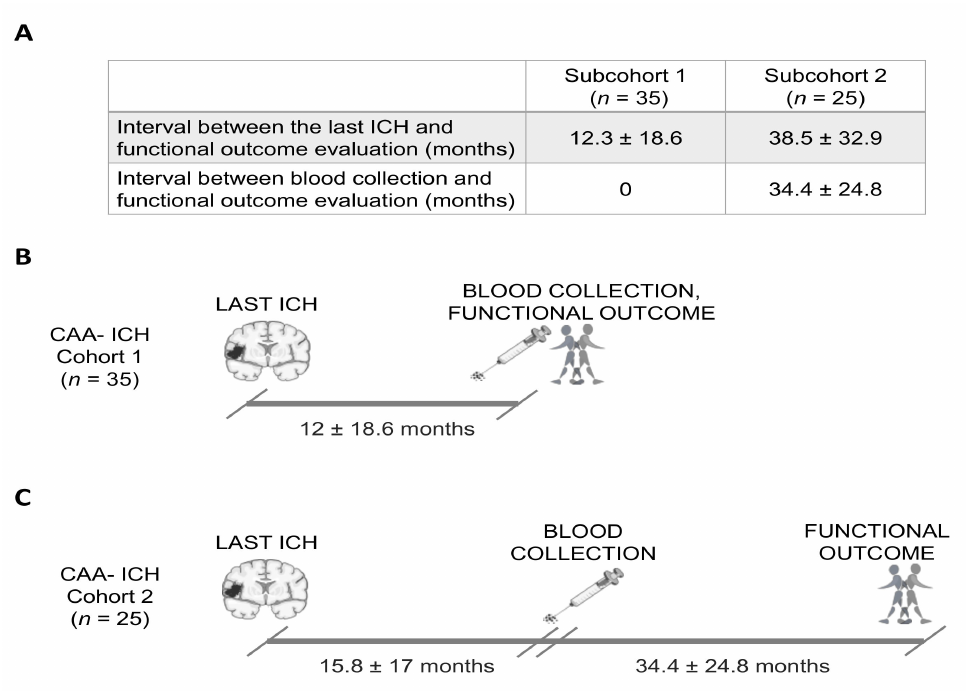
Figure A1. Schematic representation of the cerebral amyloid angiopathy (CAA)–intracerebral hemor- rhage (ICH) cohort according to the functional outcome evaluation time point. ( A ) Summary table of the time intervals in the two subcohorts. ( B ) CAA–ICH subcohort 1 refers to individuals whose functional outcome was assessed at the blood collection date, 12 ± 18.6 months after the last ICH (mid-term outcome). ( C ) CAA–ICH subcohort 2 refers to individuals in which functional outcome was assessed 34.4 ± 24.8 months after the blood collection date (long-term outcome). Months are expressed as mean ± SD (standard deviation). Parts of this figure were supported by Servier Medical Art with permission under the Creative Commons Attribution 3.0 Unported